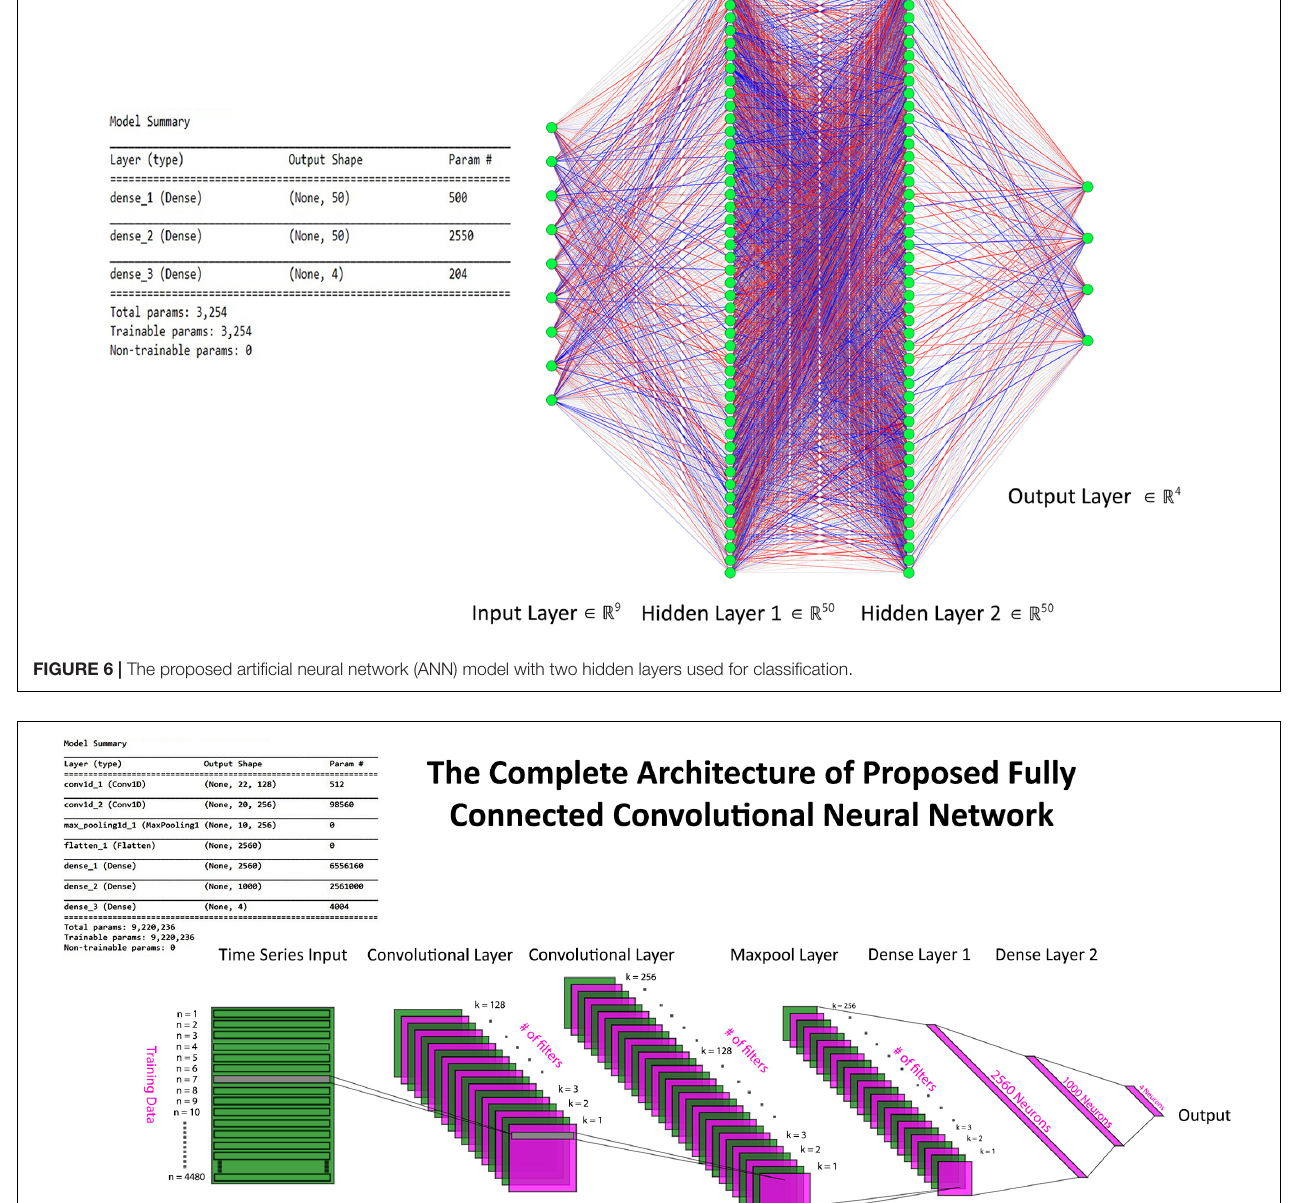
where the depth of data remains the same, whereas width and height are reduced to half in case of max pooling with a stride having a value of 2. Input data after passing through a series of convolution and pooling layers are flattened and fed into the fully connected layers to perform the classification task. The